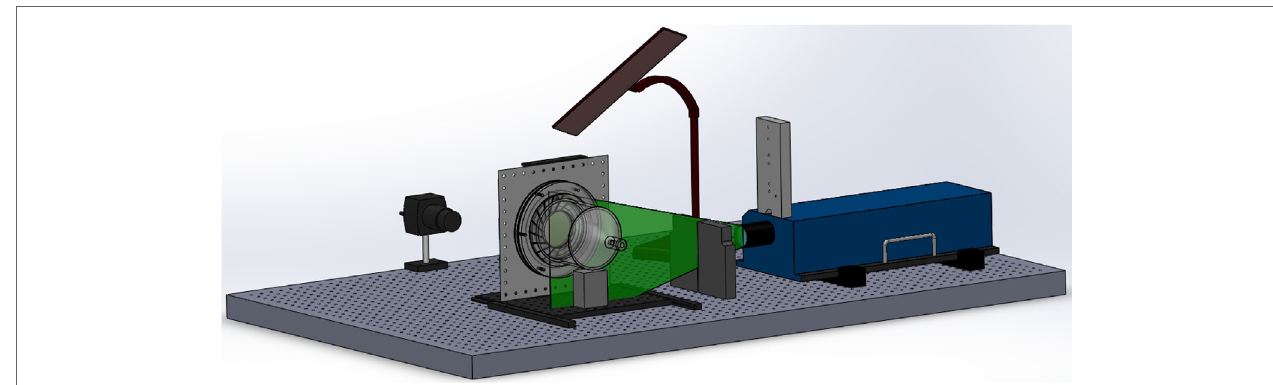
FigUre 3 | setup of the PiV measurement .